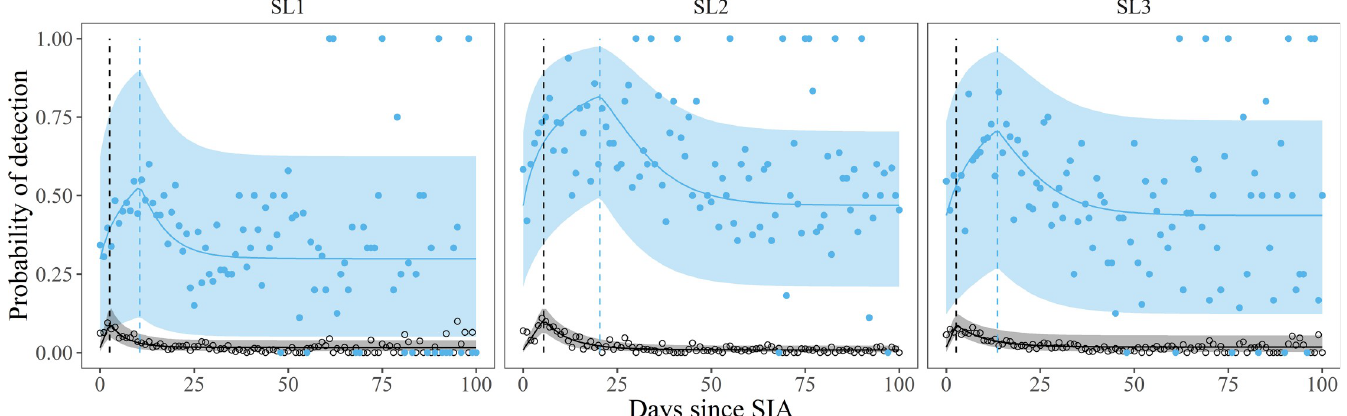
Fig 6. Peak ES detection of Sabin occurs later than in AFP after mass supplemental immunization activities (SIAs). The duration of the delay varied by type–with ES peaking later than AFP by 8, 15, and 11 days for SL1, SL2, and SL3 respectively. These delays suggest ES is able to detect significant amounts of secondary transmission after SIAs that is not typically captured in the AFP surveillance system. Figure elements are colored blue for ES and black for AFP. The dots represent observed detection rates across all of Pakistan. The solid lines represent mean model predictions and the ribbons represent 95% credible intervals across all of Pakistan. The vertical dashed lines indicate the timing of peak detection rates for each surveillance system. The panels group data by serotype: SL1, SL2, and SL3.